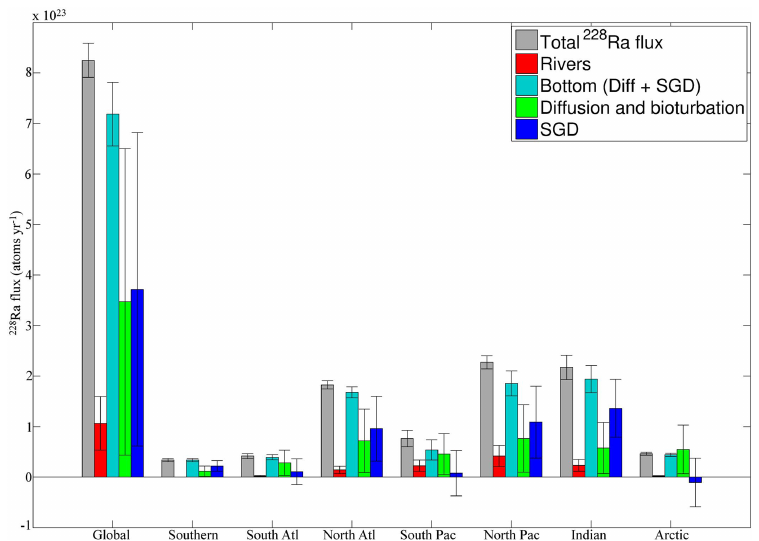
Figure 8. 228 Ra sources by basin, divided into riverine input, diffusion from sediment and SGD. Only logarithmic least-squares results are shown. Fluxes are divided the following way: Regions 1 and 38: Southern; 2–4: South Atl; 5–16: North Atl; 17–18 and 26–27: South Pac; 19–25: North Pac; 28–34: Indian; 35–37: Arctic. Table 6. Estimates of 228 Ra diffusive fluxes (10 9 atomsm − 2 yr − 1 ) from fine-grained sediments (muds) by different methods. The studies which do not separate SGD and diffusion are in bold. Reference Study area Method Flux Santschi et al. (1979) Narragansett Bay Inventory 52 Moore et al. (1995) Amazon shelf Inventory 110 Rama and Moore (1996) North Inlet Sediment profile 5 Hancock et al. (2000) Zecks Lagoon Benthic chamber Port Royal Sound